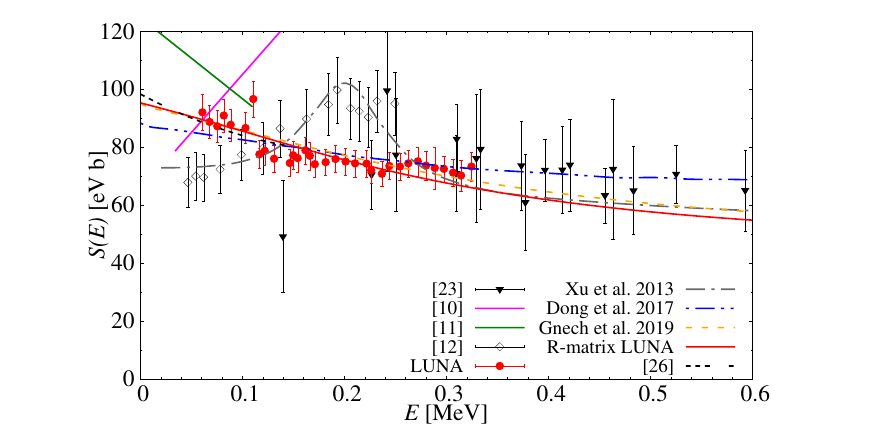
Figure 3. Astrophysical S-factor for the 6 Li( p , γ ) 7 Be reaction as obtained by LUNA in red [17]. Pre- vious experimental data and theoretical evaluations are also shown for comparison. The solid red line represents an R-matrix fit of LUNA data and data from [23].